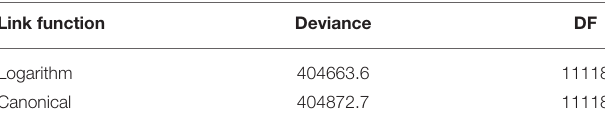
TABLE 5 | The residual deviance and degrees of freedom for a Tweedie GLM with differing link functions using Model 1